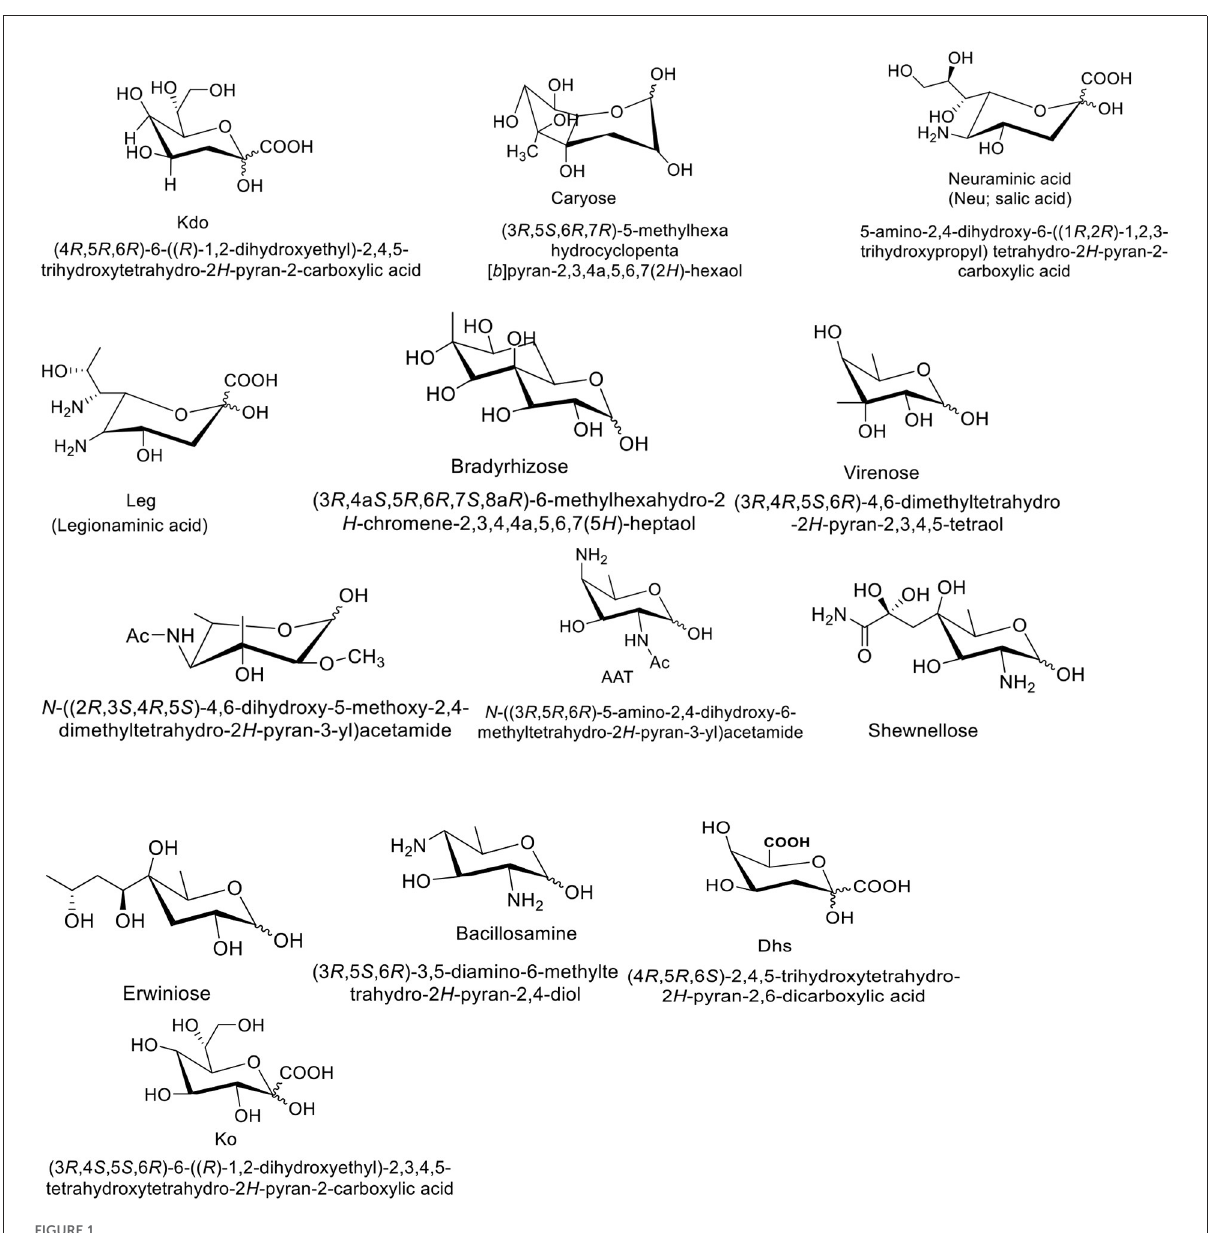
FIGURE1 Structures of some unique bacterial monosaccharides.